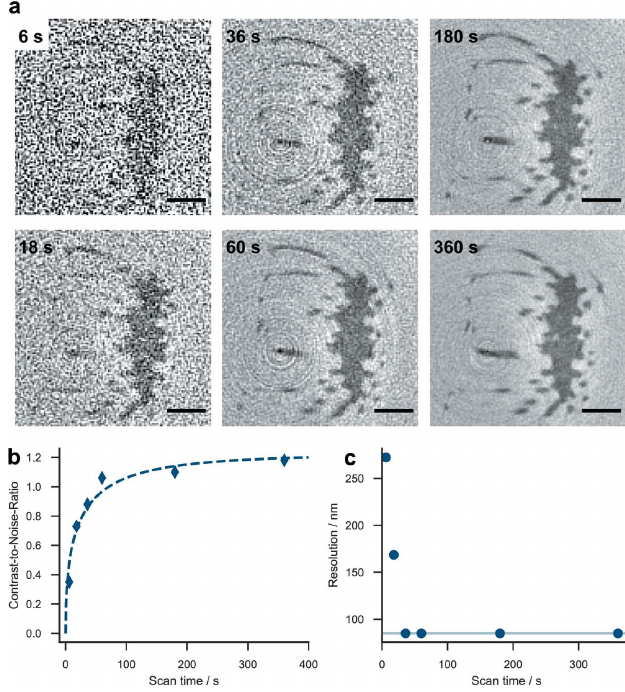
Figure 3 Fast Zernike phase contrast tomography with a photon-counting detector. ( a ) Reconstructed slices of a spider attachment hair with different scan times. ( b ) CNR for the different scan times. For details of the fit, refer to Flenner et al. (2020 c ). A high CNR is already reached after 60 s. ( c ) Half-period resolution as calculated from the FRC. The effective pixel size (85 nm, solid horizontal line) limits the resolution after 36 s scan time. The scale bar indicates 2 m m.